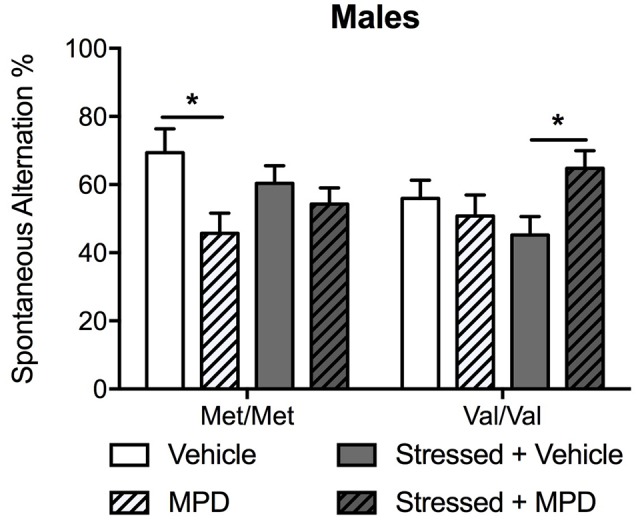
Chronic treatment with MPD had opposite effects on working memory in non-stressed Met/Met carriers and in stressed Val/Val mice. Working memory was determined with the spontaneous alternation assessed in the T-maze 13 days after stress. Data are presented as mean ± SEM in male mice. *p < 0.05 (n = 9–14 per group).